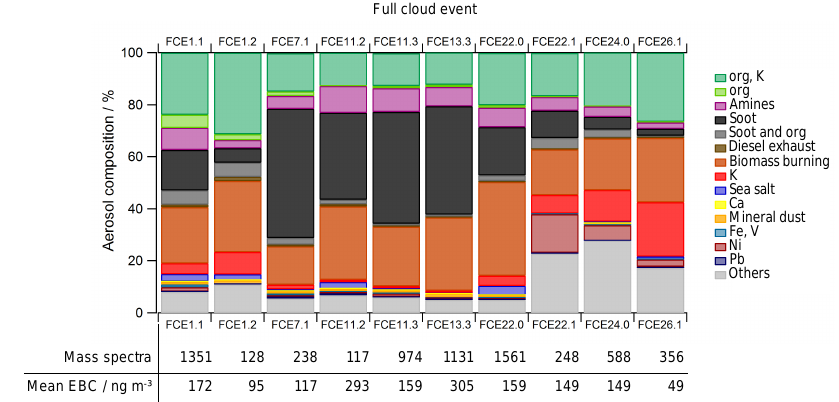
Figure 9. Cloud residue composition during full cloud events (FCE). The number of obtained single particle mass spectra and the mean EBC concentration per event is given below the graph. Only FCE with more than 100 mass spectra are included (see Table 1).